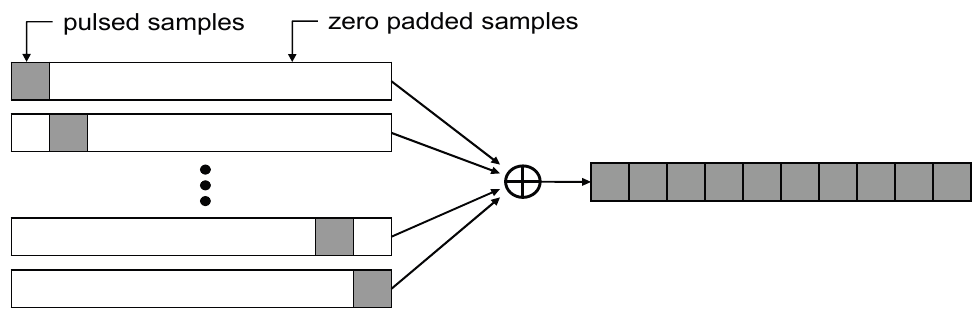
Figure 6. Principle of the randomized pulse sequence scheme (e.g., the RTCM SC-104 suggestion).